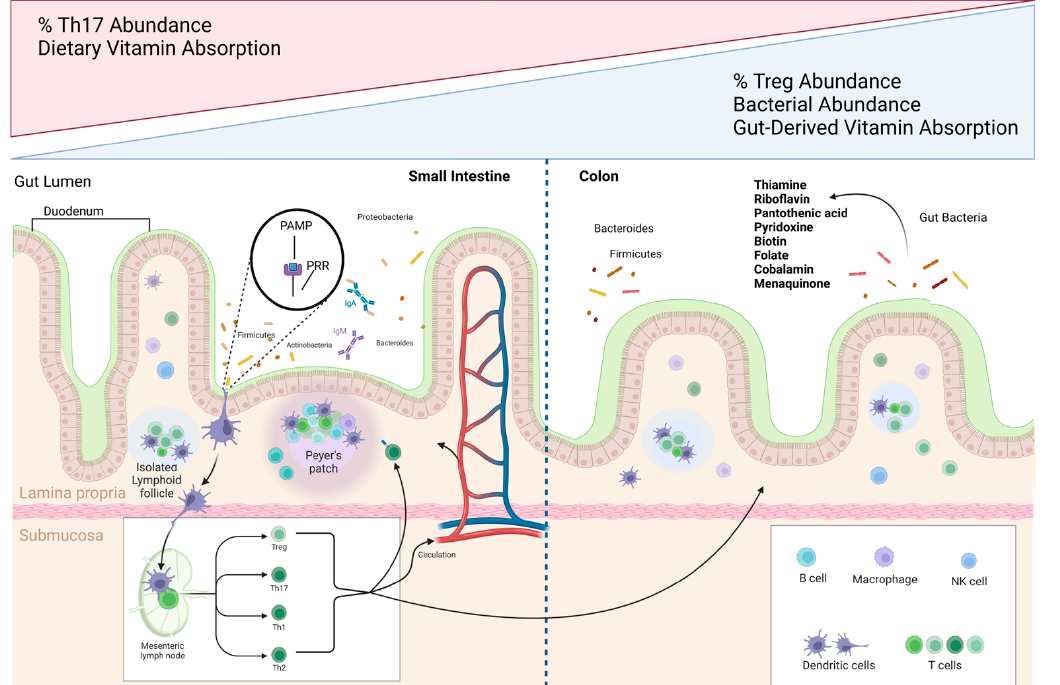
Figure 1. The gastrointestinal (GI) tract contains varying frequencies and distributions of immune cells and vitamin-producing bacteria. The gut-associated lymphoid tissue (GALT) is essential to host immune defense and is comprised of mesenteric lymph nodes (MLNs), isolated lymphoid follicles (ILFs), and Peyer’s patches—found mainly in the small intestine. Gut microbes can express pathogen-associated molecular patterns (PAMPs) and immune cells recognize them through their pattern recognition receptors (PRRs). Antigen-presenting cells (APCs) undergo maturation upon PAMP-PRR interactions on their cell surfaces, which can then lead to the differentiation of naïve CD4 + T cells in the MLNs and outside the intestines and boost T- and B-cell-related responses. Th17 and Treg cells are the most abundant T cells in the gut and their concentration gradients along the tract share an inverse relationship. Bacterial abundances also vary along the GI tract, with the duodenum containing the lowest bacterial abundance which increases towards the colon, dominated by Firmicutes and Bacteroides in healthy individuals. Gut-derived vitamins are mainly generated and absorbed in the large intestine, while dietary vitamins are absorbed in the small intestine. Vitamin K2 and most members of the water-soluble B vitamins—thiamine, riboflavin, pantothenic acid, pyridoxine, biotin, folate, and cobalamin—are produced by gut bacteria and play many roles in immune function.